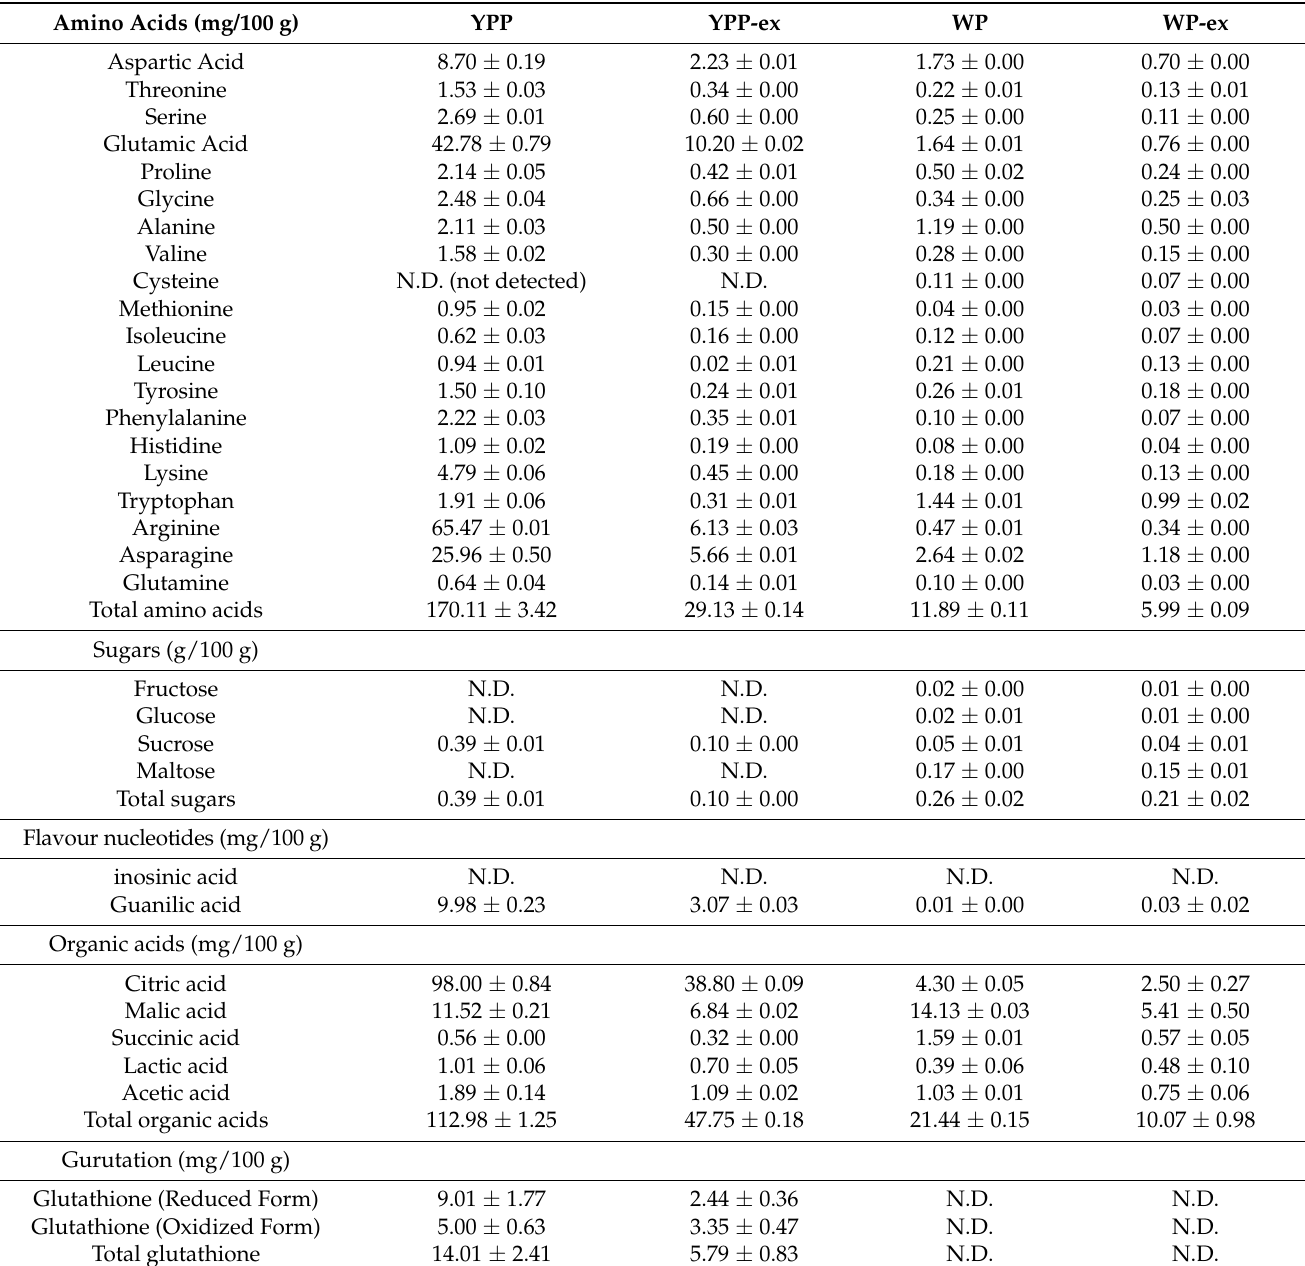
Table 3. Comparison of non-seasoned YPP, YPP-ex, CP, and CP-ex components. Amino Acids (mg/100